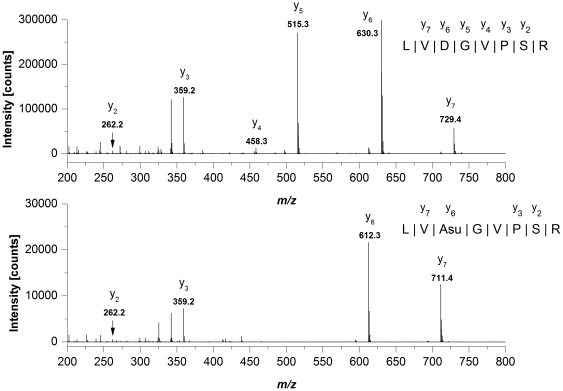
Low-energy CID mass spectra and resulting amino acid sequence of the doubly protonated Mab1 light chain peptide containing Asp-56 (upper panel) and Asu-56 (lower panel) at m/z 421.7 and 412.7.